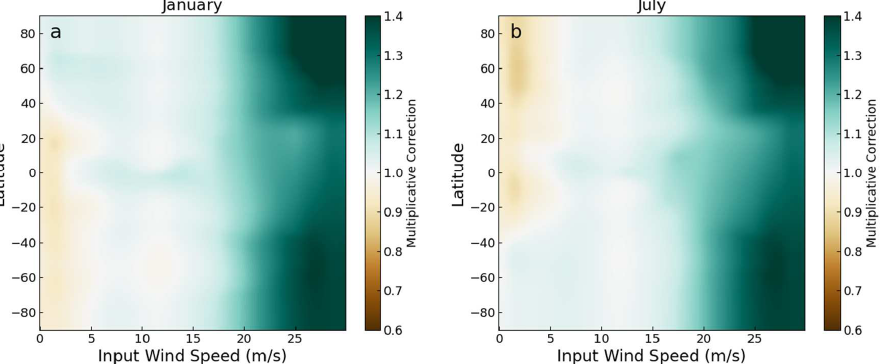
Figure 4. Color-coded representations of the wind speed adjustment factor applied to ERA5 winds as a function of ERA5 wind speed and latitude. We show the adjustments for two example months, January ( a ) and July ( b ). Adjustments for all other months are qualitatively similar, except for the seasonal variation of the low-speed corrections described in the text.